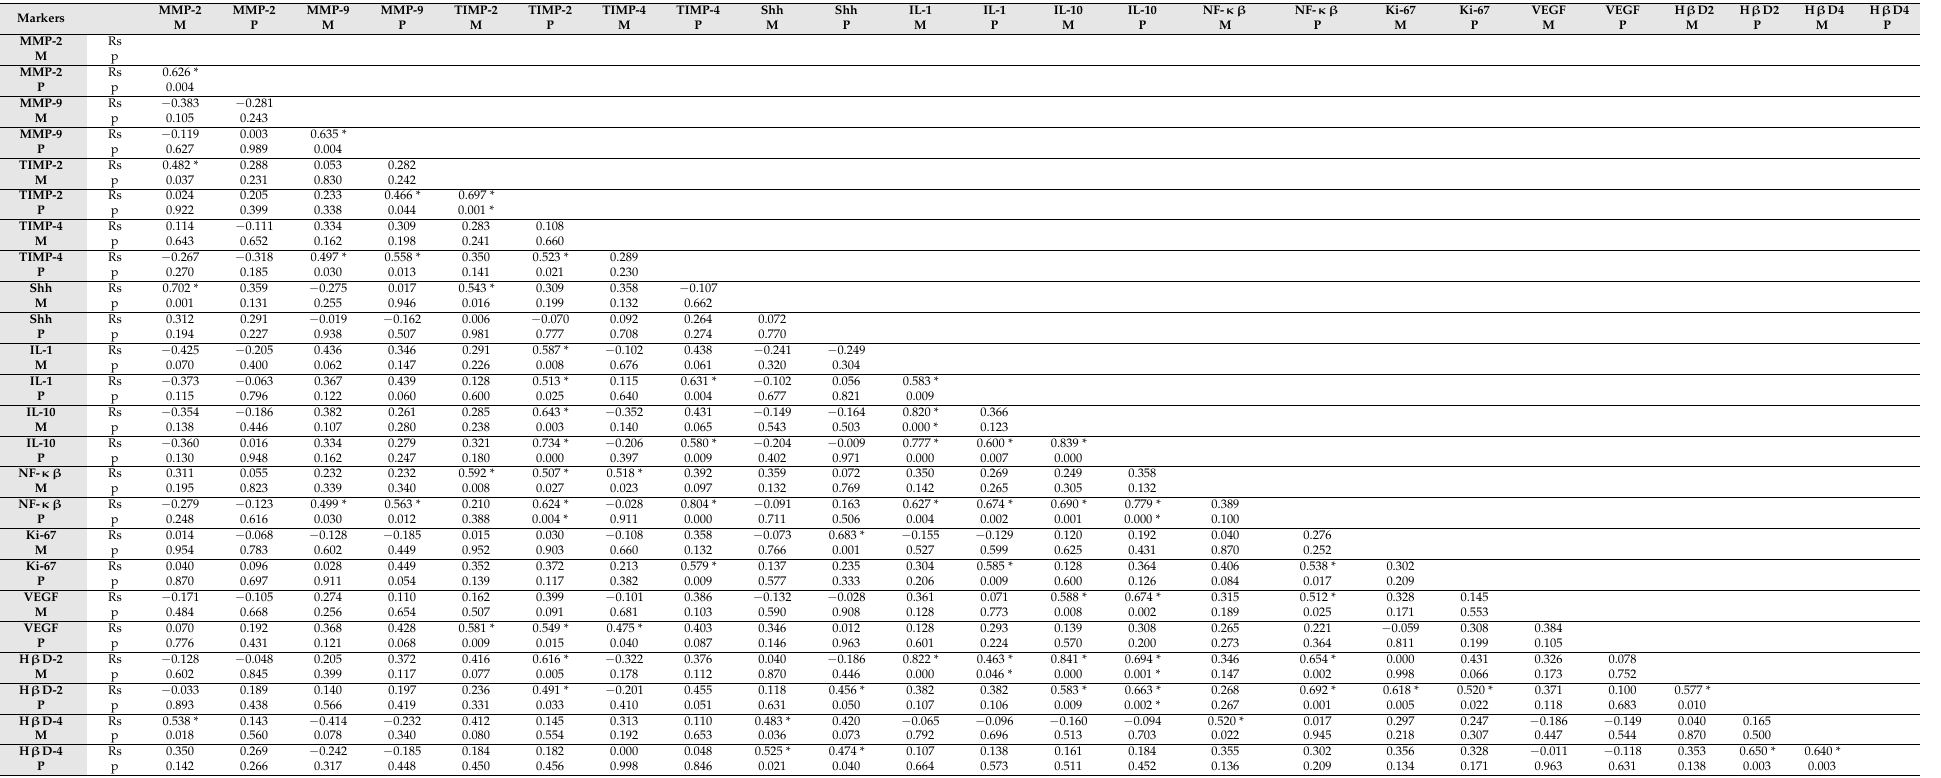
Table 3. Spearman’s rank correlations between different cell